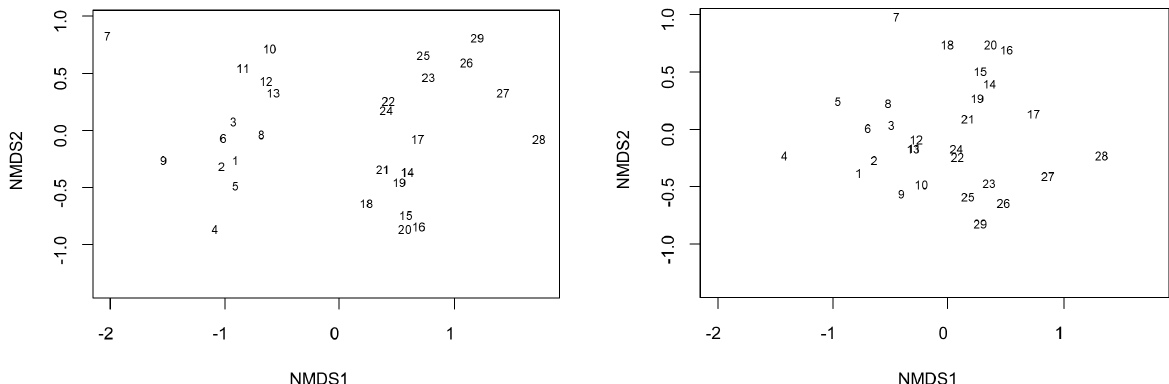
Figure 3. Non-metric multidimensional scaling (NMDS) ordination plots: based on a) species similarity and b) genus similarity. Auca Mahuida sites from 1 to 13, Tromen sites from 14 to